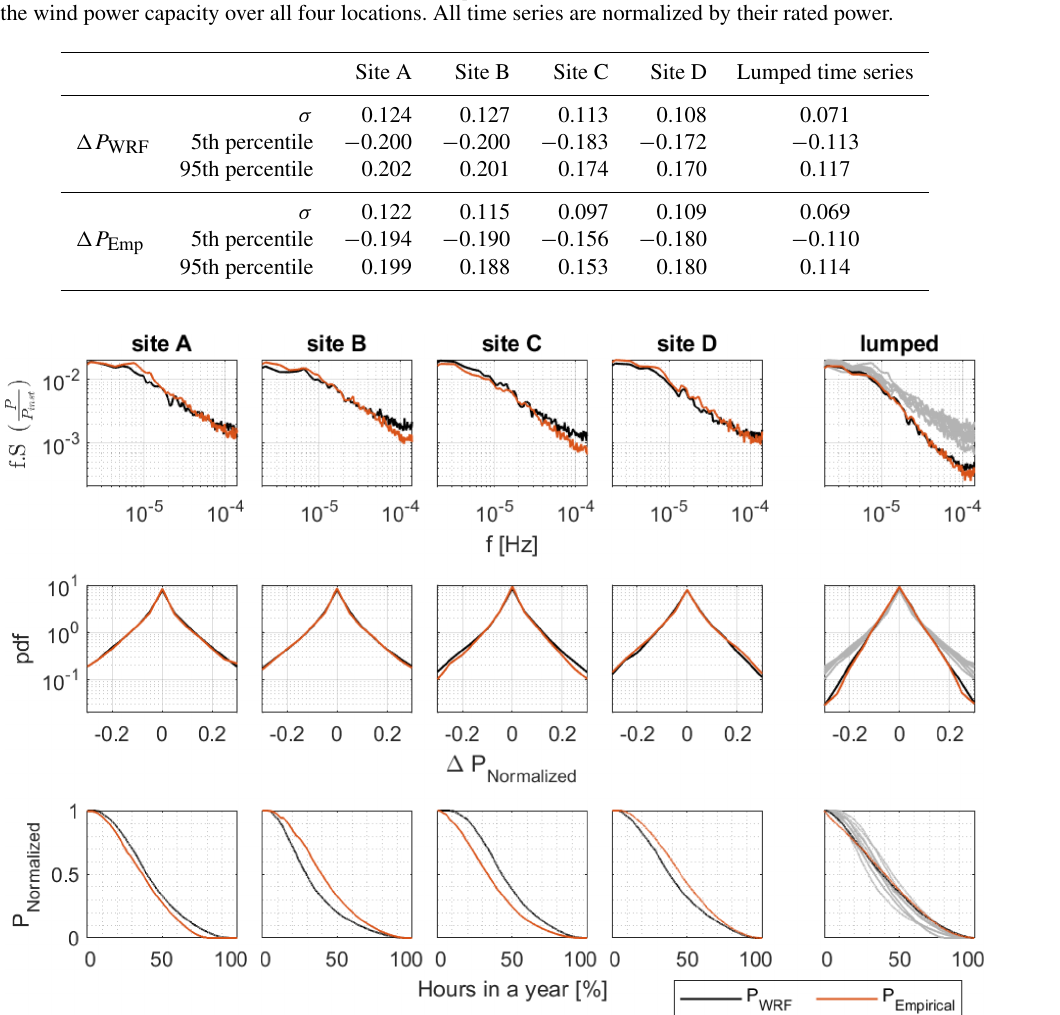
Figure 3. PSD (top), pdf of hourly step-change functions (middle), and duration curves (bottom) of hourly wind power output time series per installed capacity ( P ). Black colors represent results developed from WRF-generated data. Red colors represent results developed from P inst measured data. The first four columns represent data from individual sites. The last column represents the lumped time series of all four sites, with an equal distribution of the wind power capacity over all four locations.